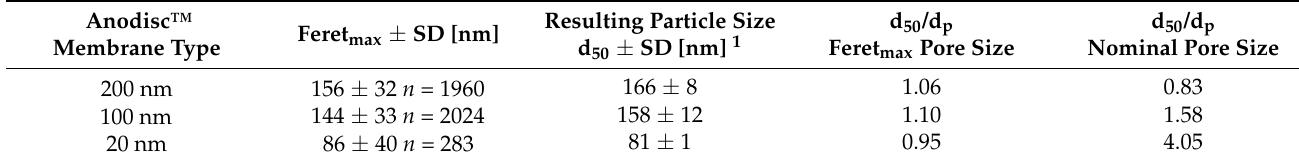
Table 1. Feret max pore diameters calculated from SEM images of Anodisc ™ membranes, resulting particle sizes of the MCT emulsions (10% SL) and particle size to pore size ratios (d 50 /d p ) related to either Feret max diameter or to the nominal pore size of the membranes ± standard deviation ( n = number of measured